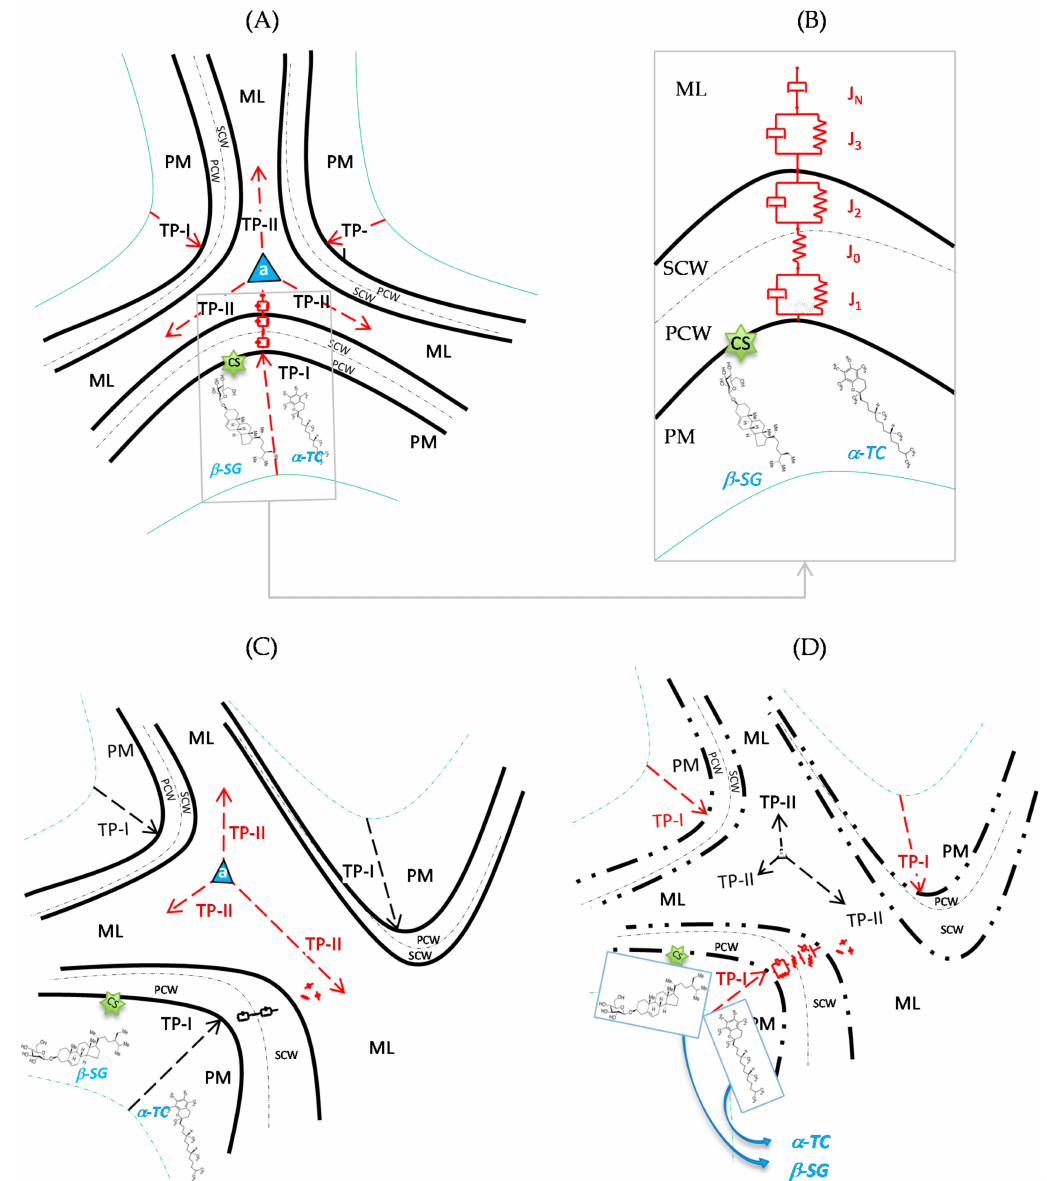
Scheme 3. Biophysics underlying softening and decompartmentalization as induced by heat. At the equilibrium, the mechanical stress induced by cell turgor is distributed at tricellular junctions joining the parenchymatic cells with two stress components: the first component acting at cell wall level on the plane of each cell-to-cell contact, and the second component acting at middle lamella level as radial stress separating the cells at the tricellular joining corners ( A ). Polymer assemblies contribute to counter balance turgor by stressing effectively their elastic, viscoelastic and plastic elements from middle lamella to primary and secondary cell wall microdomains ( B ). Heating causes partial disassembling of plasma membrane (reducing turgor) and pectin degradation, mainly through enzymatic and chemical reactions. When pectin degradation is limited in the middle lamella microdomain, the survivor second stress component of turgor will be able to separate the cells without rupture of their walls, with sterols and tocopherols remaining entrapped by the integer walls ( C ). When pectin degradation extends from middle lamella to primary and secondary cell wall, the survivor first stress component of turgor will be able to cause wall loosening (or partial rupture) and effective decompartmentalization of sterols and tocopherols ( D ). TP-I, turgor pressure I component; TP-II, turgor pressure II component; PCW, primary cell wall; SCW, secondary cell wall; PM, plasma membrane; ML, middle lamella; CS, cellulose synthase; β -SG, glucoside of β -Sitosterol; α -TC, α